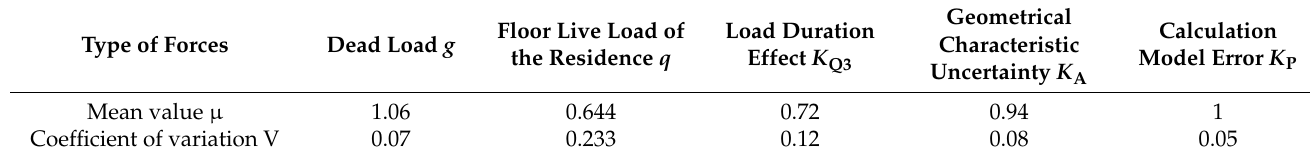
Table 2. Statistics of parameters.